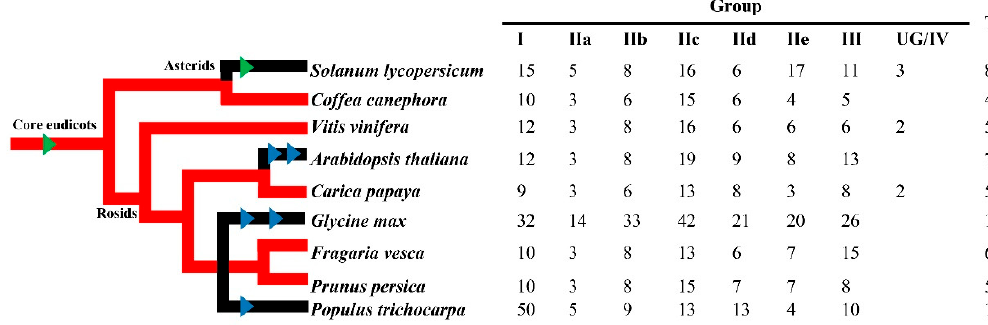
F. vesca , and P. persica ; but less than S. lycopersicum , A. thaliana , G. max , and P. trichocarpa (Figure 1).